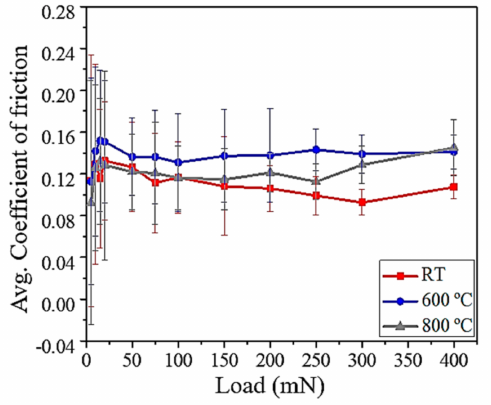
Figure 8. Coe ffi cient of friction (COF) versus load measured in nano-scratch